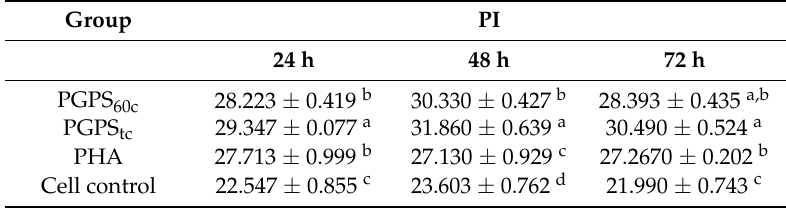
Table 5. PI value of peripheral lymphocyte cell cycle of each group at different time points ( n = 4). Group